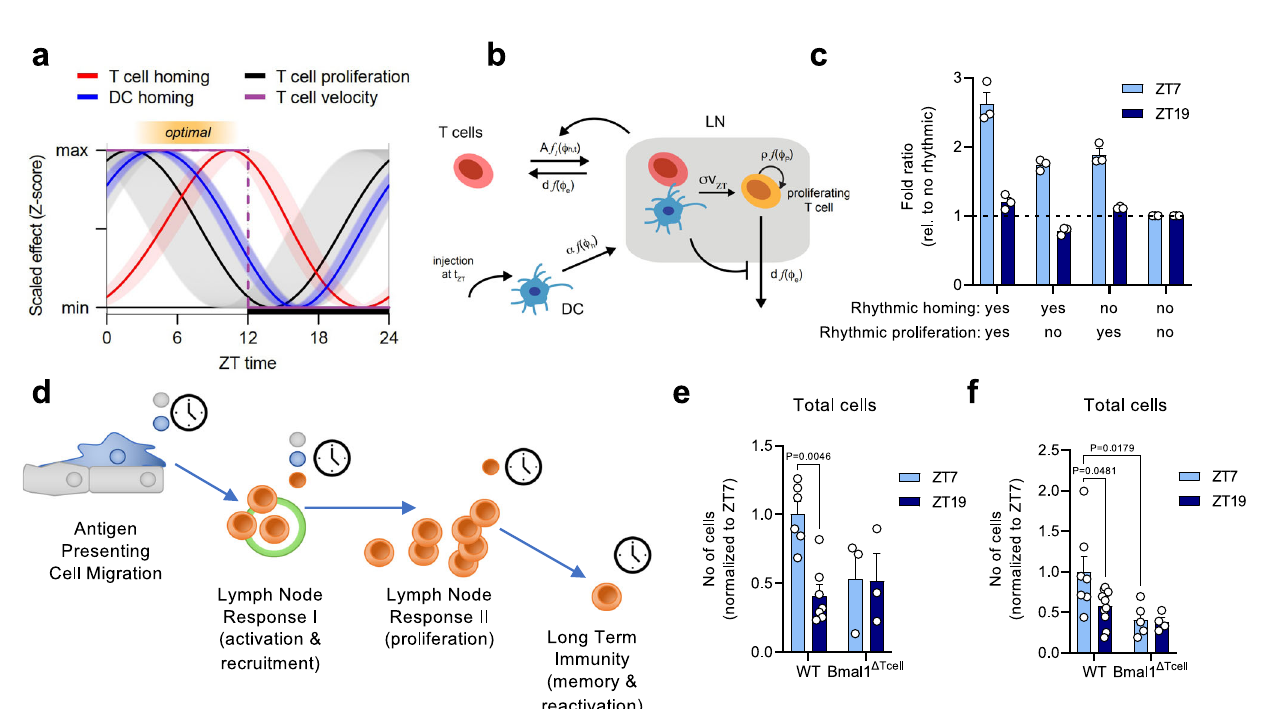
Fig. 4 | Modeling a multi-stage process for adaptive immunity by integrating cell-intrinsicrhythms.a DynamicsoftheindividualrhythmiccomponentsofTcell (red) and dendritic cells (DCs, blue) migration to the lymph node (LN), aswell asT cell proliferation (black) as predicted by the mathematical models (ID1-3, Supple- mentary Table 1) with Z-score for each dynamic being shown. The solid lines indi- cate the mean (for T cell homing) or the best fi t (for DC homing and T cell proliferation), while colored shaded areas represent 95%-con fi dence intervals.